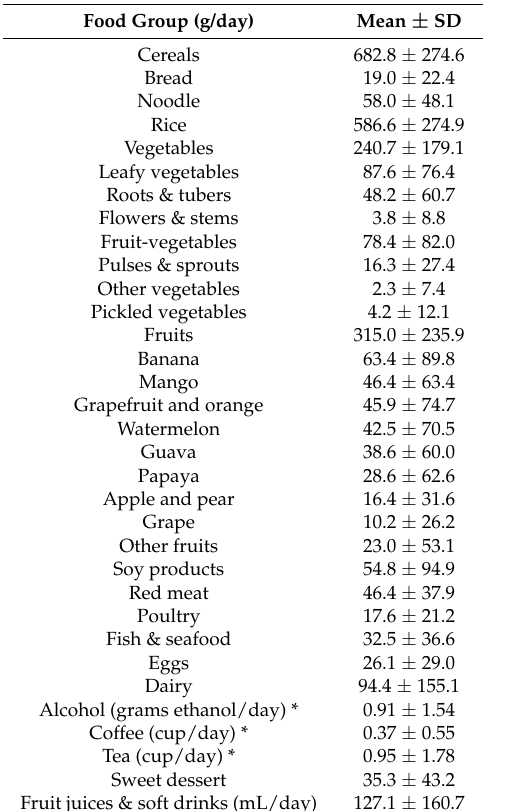
Table 2. Average food intake by pregnant women in Vietnam,